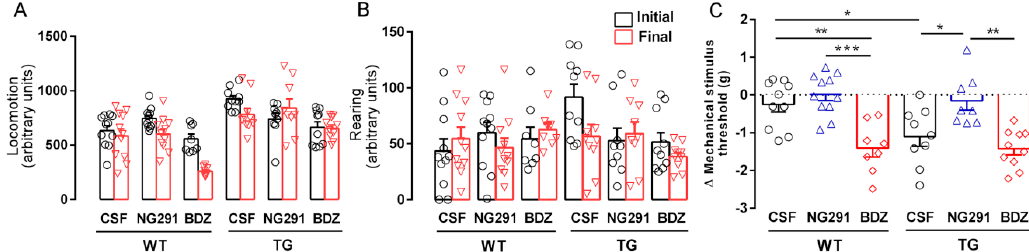
Figure 2. Kallikrein–kinin system does not change motor activity but has an influence on mechanosensitivity of WT and TG mice. Motor activity evaluation of WT and TG mice, submitted or not to treatments. Panel ( A ): locomotion. Panel ( B ): rearing. Panel ( C ): mechanosensitivity; WTCSF ( n ) = 11, WTNG291 ( n ) = 11, WTBDZ ( n ) = 8, TGCSF ( n ) = 10, TGNG291 ( n ) = 9, TGBDZ ( n ) = 10. Histograms and vertical bars are means ± SEM. Data were analyzed with one-way ANOVA followed by Tukey’s multiple comparison test. * p < 0.05; ** p < 0.01; *** p < 0.001.